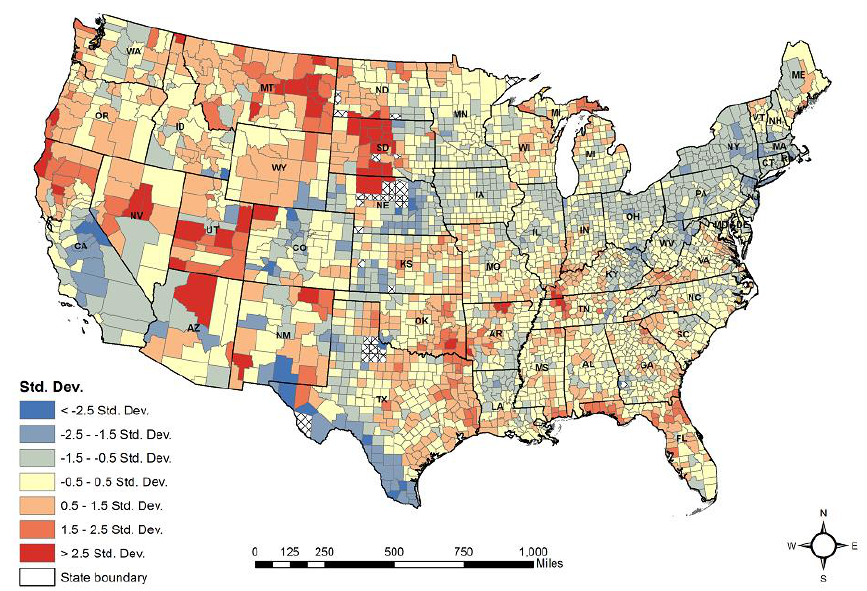
Figure 3. The residuals of the OLS model.